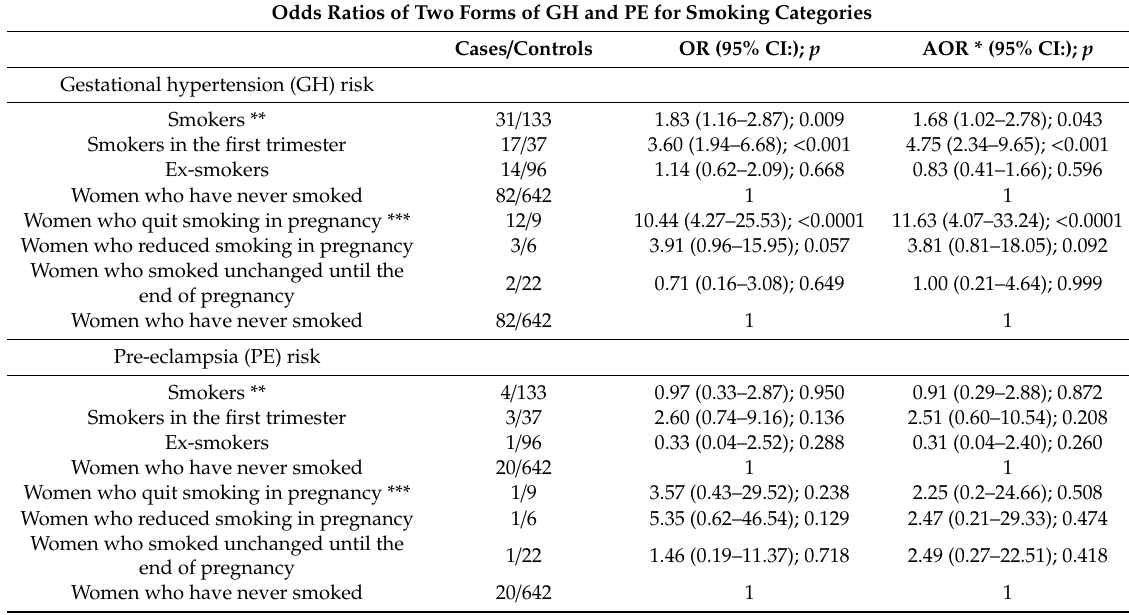
Table 2. Theadjustedoddsratiosofgestationalhypertension(GH)andpre-eclampsia(PE)forsmokingcategories. Odds Ratios of Two Forms of GH and PE for Smoking